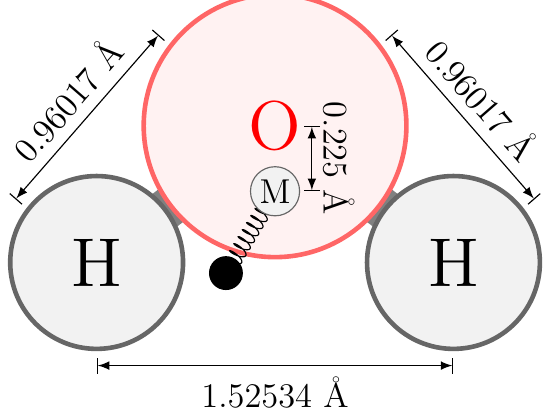
Figure 4. Rigid water geometry after QM optimization in the gas phase at the B3LYP/QZ4P level of theory. All bonds are constrained during simulation and the bond angle is enforced by an extra bond between the hydrogens. The location of the off-site (M) particle and its offset are included in the figure. The COS particle is attached to the M-site.